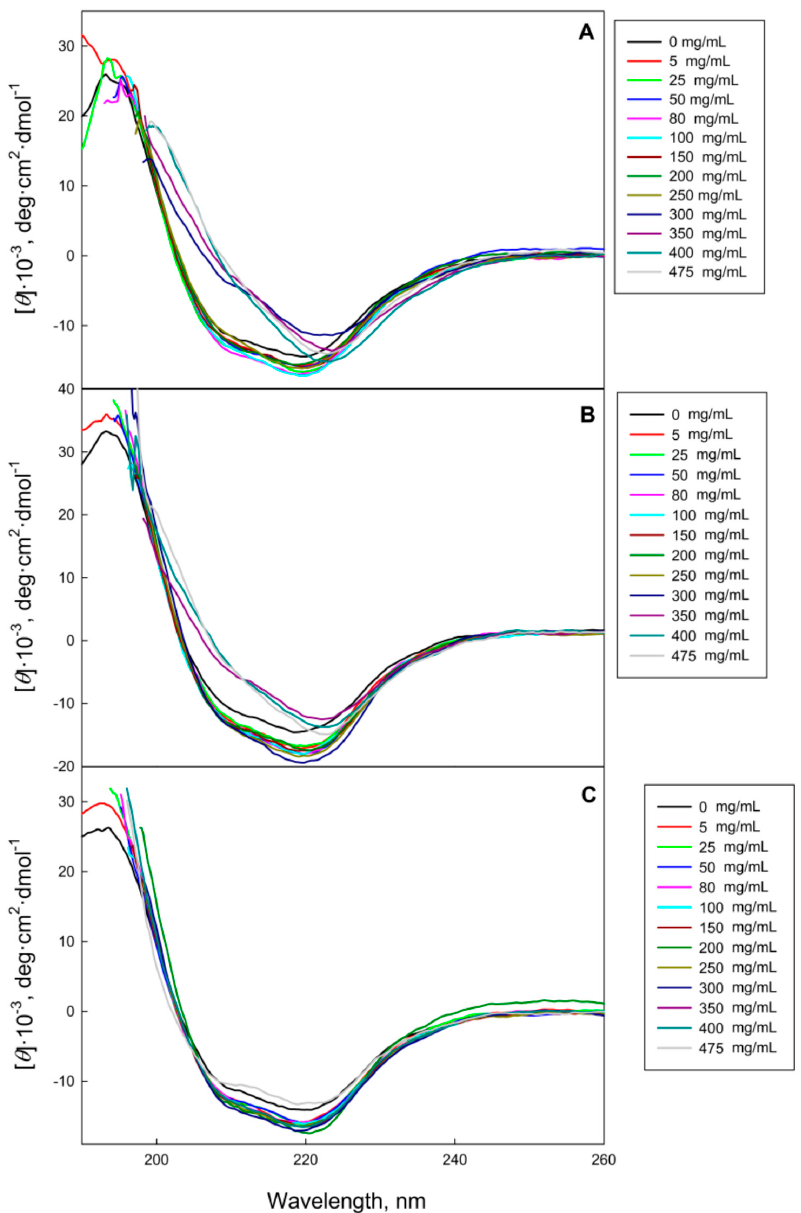
Figure 2. Far-UV CD spectra of GGBP in the presence of PEG of different molecular weight. ( A ): PEG-12000; ( B ): PEG-4000; ( C ): PEG-600.